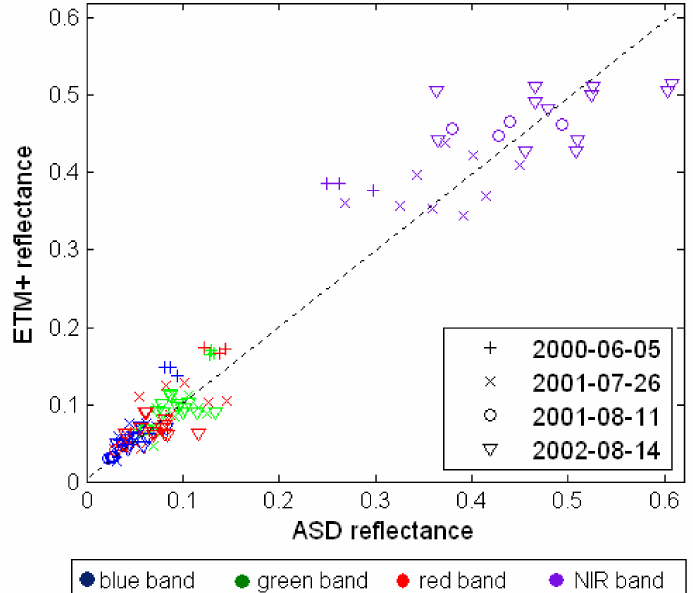
Figure 14. Comparison of reflectances measured (by ASD) and estimated (by REFLECT) for Landsat-7 ETM+ images.